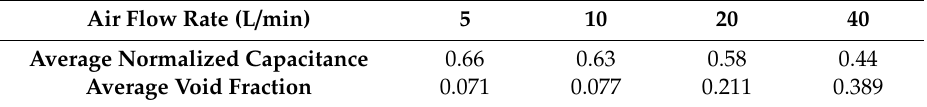
Table 2. Average void fraction data for di ff erent air flow rates using the single-sensor